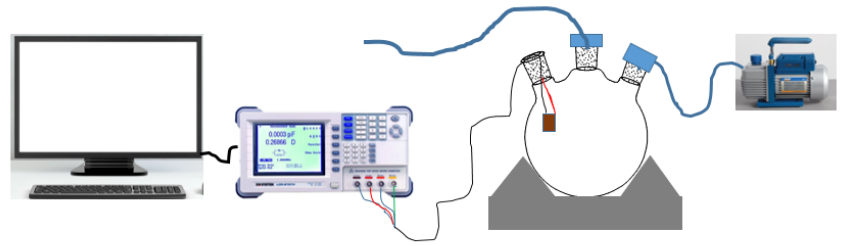
Figure 2. Illustration of the gas sensing setup used in this study.